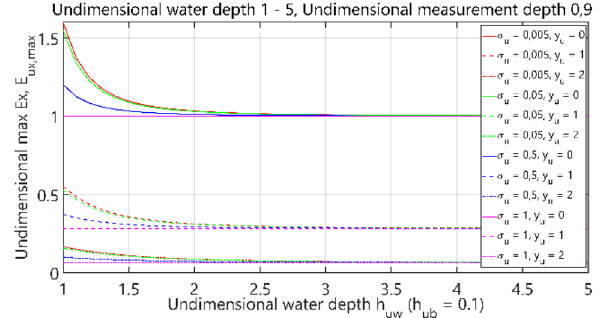
Figure 32. Dependence of E ux,max on h uw ( h ub = 0.1).